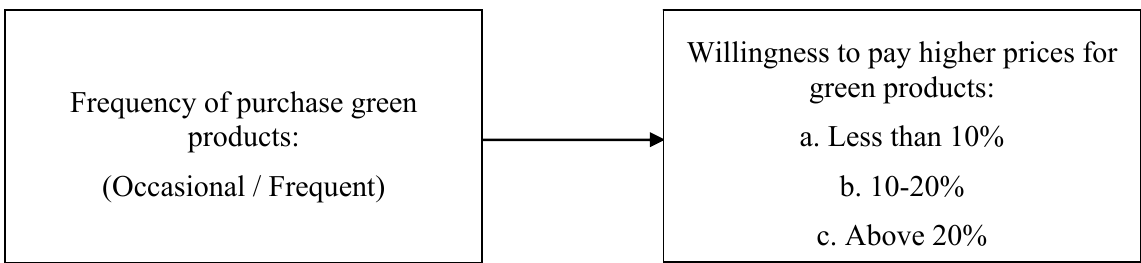
Fig. 2. Relations of purchase type to willingness to pay higher prices for green